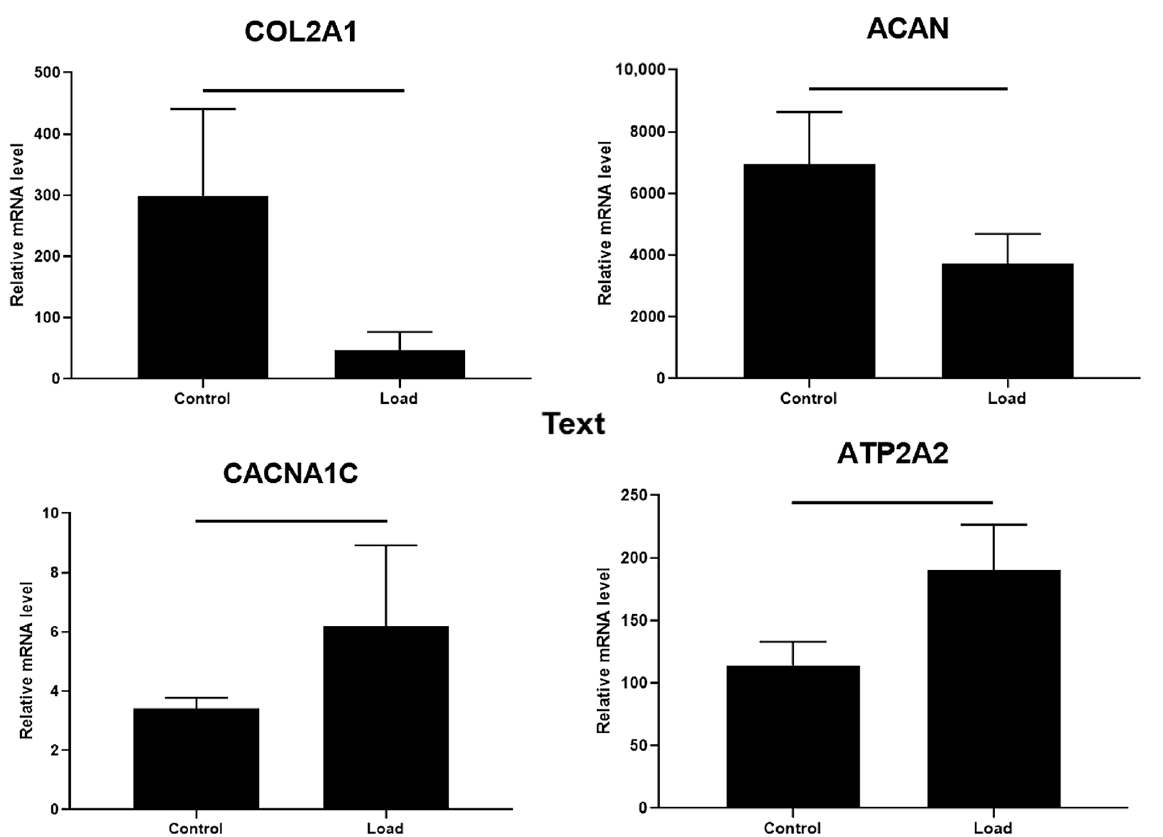
Figure 9. The effect of mechanical load on human OA cartilage explants. The expression of collagen 2 (COL2A1), aggrecan (ACAN), L-type channel subunit CaV1.2 (CACNA1C) and Serca2 pump (ATP2A2) genes in cartilage explants under regular growth conditions with/without mechanical load as described in the Methods section. Relative transcript level after normalization to the geometric mean of housekeeping B2M and RPS9 genes are shown. Data are presented as mean ± SD and are significant at p ≤ 0,05 from not less than three repeats of three patients’ cartilage explants. Control—cartilage samples without load.